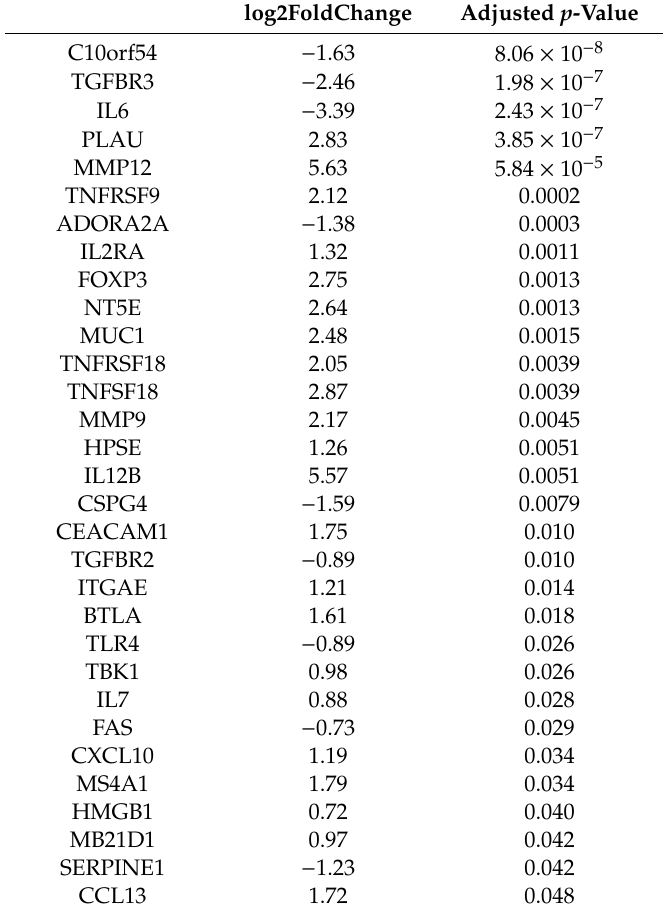
Table 1. Significantly deregulated genes in the tumor / normal